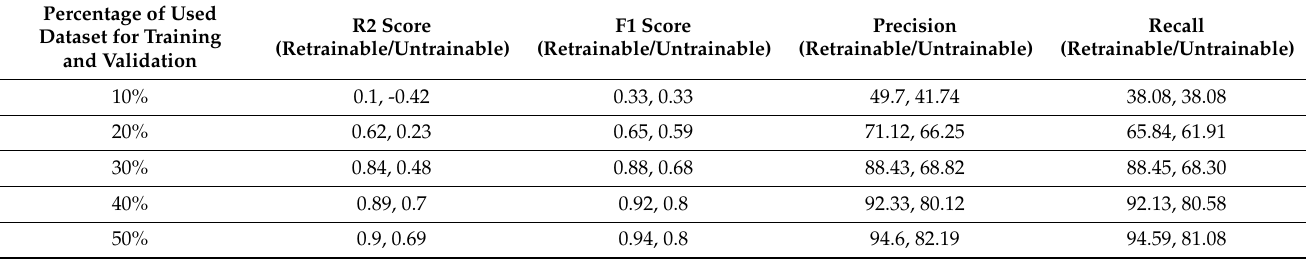
Table 4. A table of methods including an untrainable encoder and retrainable encoder’s R2 score, F1 score, precision, and recall.